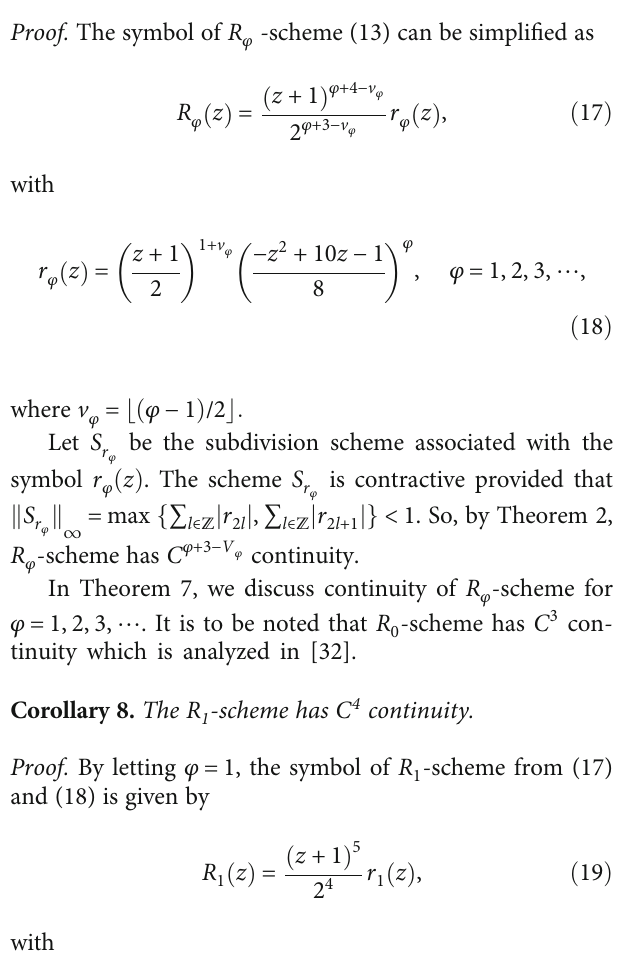
), continuity ( C ), and HC of R φ R